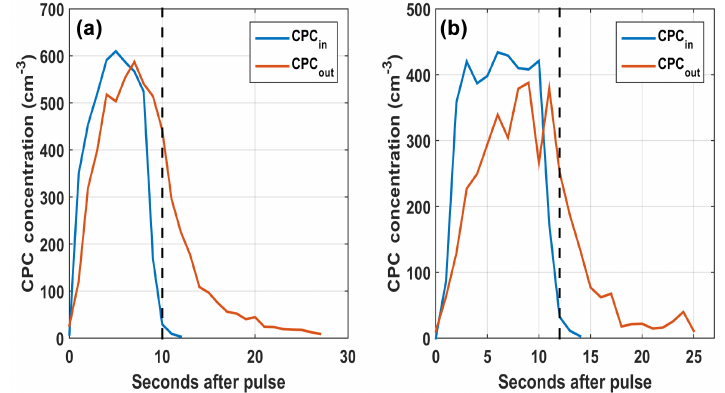
Figure 2. Particle concentration as a function of time for particle pulse experiments using ZINC. The blue traces are the counts measured at the entrance of the chamber (CPC in ) while the red traces are the concentrations at the output (CPC out ) . Both experiments were conducted at − 40 ◦ C with (a) at 102% RH and (b) at 110% RH, both with respect to liquid water. Particles in the red trace occurring after the vertical dashed line are outside the initial pulse duration and are inferred to have moved out of the lamina. The ratio of particles within the pulse time at the outlet versus the total particles were 78 (a) and 76% (b) ,